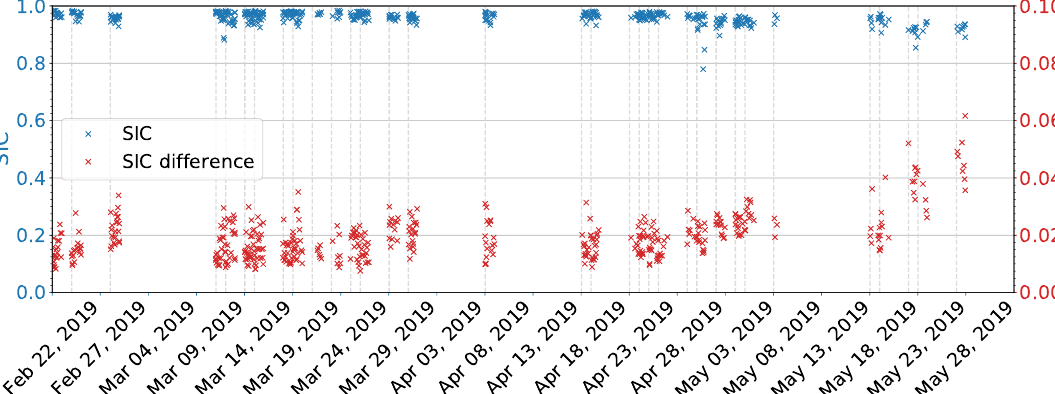
Figure 5. MODIS SIC calculated with the ice tie-point from Figure 4a plus/minus the standard deviation from Figure 4d. The blue dots show the SIC. The orange dots show the difference between the MODIS SIC resulting from varying the ice tie-point by plus/minus one standard deviation. The x-axis shows the date; the vertical lines mark the days with Sentinel-2